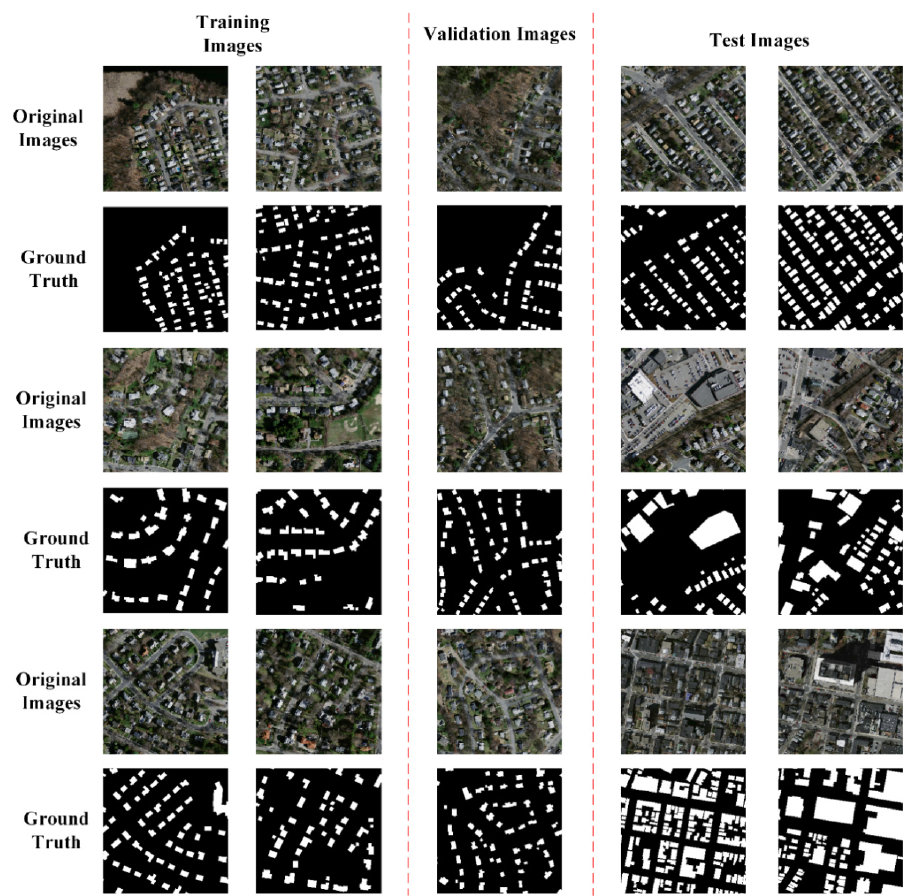
Figure 3. Several 256 × 256 sample images of Massachusetts Building dataset used in our experiments.